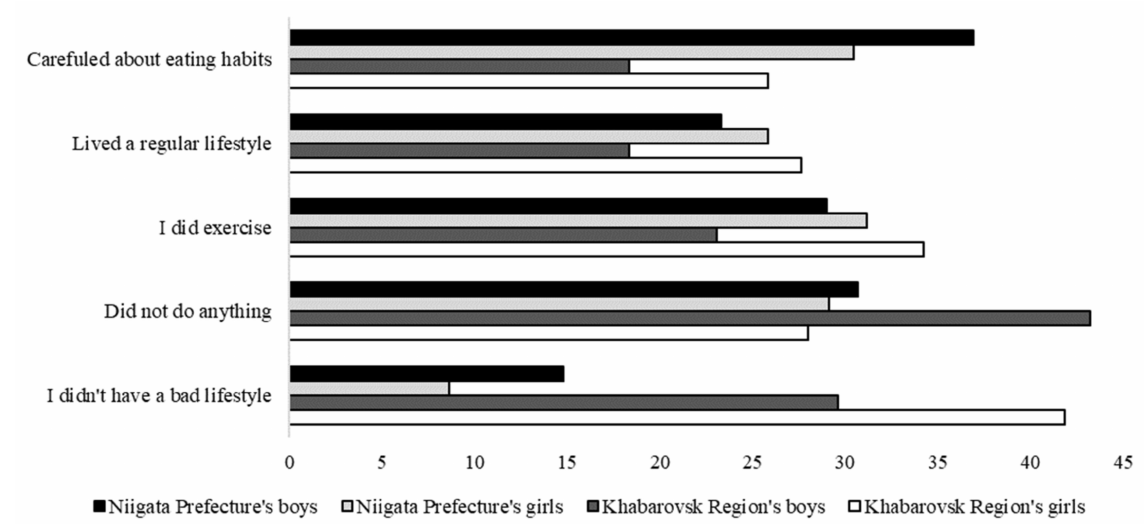
Figure 2. “What are you doing/not doing to improve your